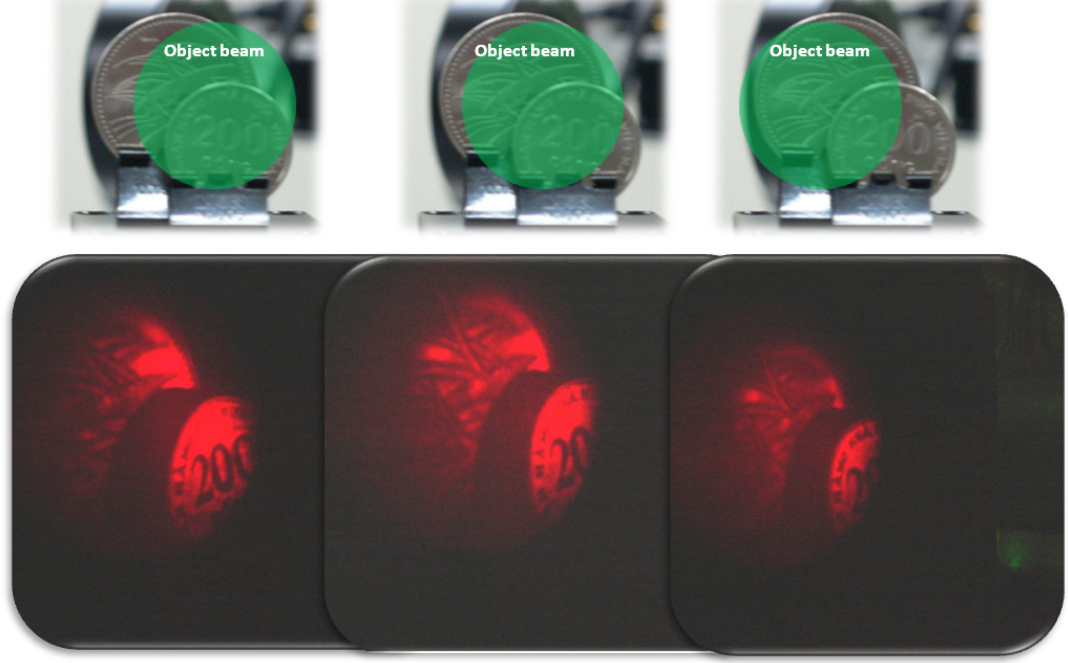
Figure 7. The top shows the photograph of the object. From left to right, coin moves laterally, corresponding hologram was reconstructed.